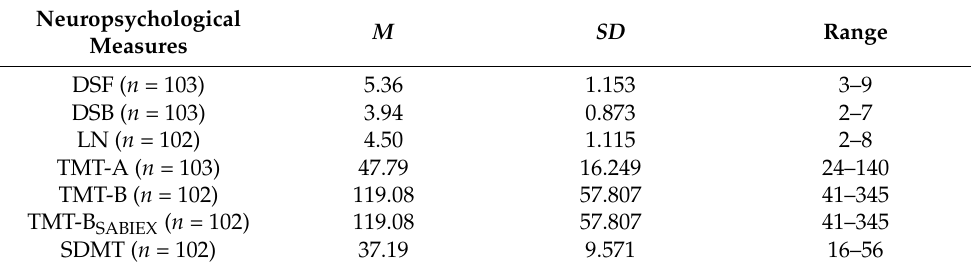
Table 3. Raw scores on neuropsychological